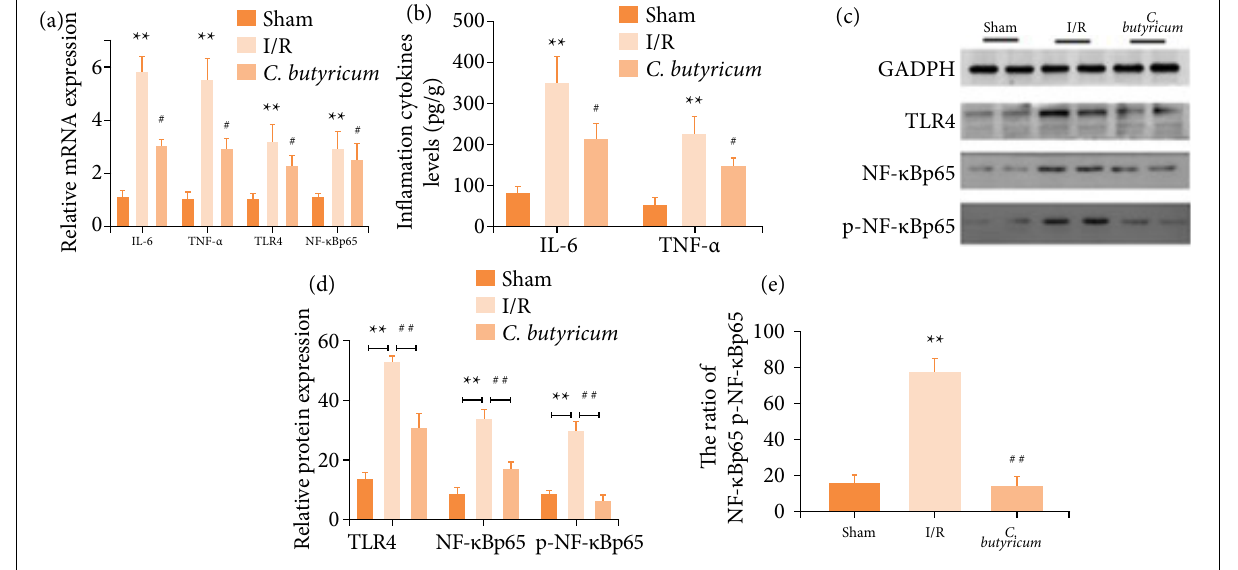
Figure 4 - TNF- α , IL-6, TLR4 and NF- κ Bp-65 levels in (a) mRNA and (b–e) protein in the liver